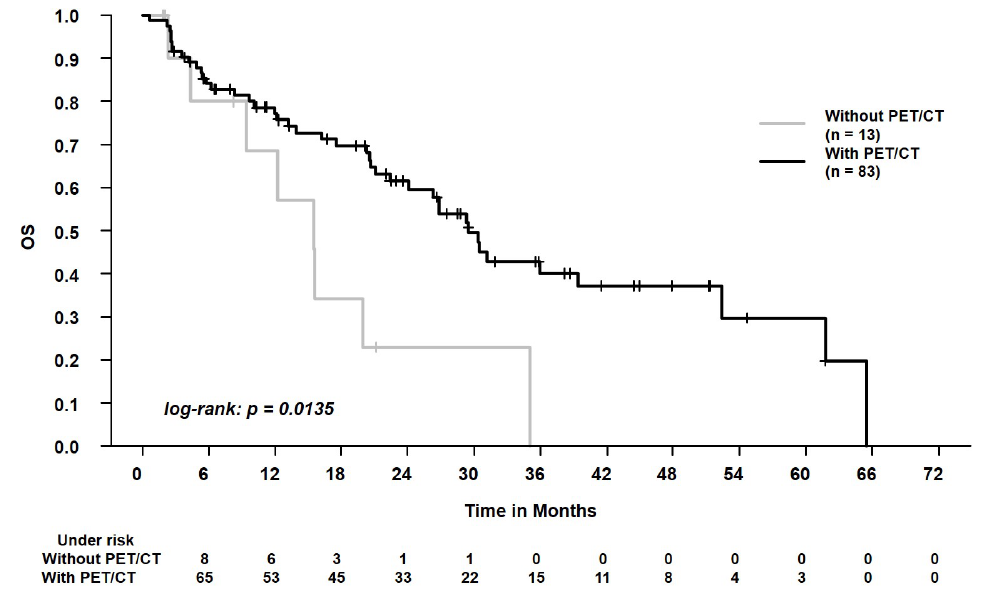
Figure 2. Overall survival (OS) in patients who were staged with positron emission tomography/computed tomography (with PET) vs. patients who were staged with conventional chest CT scan (without PET). The 2-year OS was 61.5% vs. 22.9%.